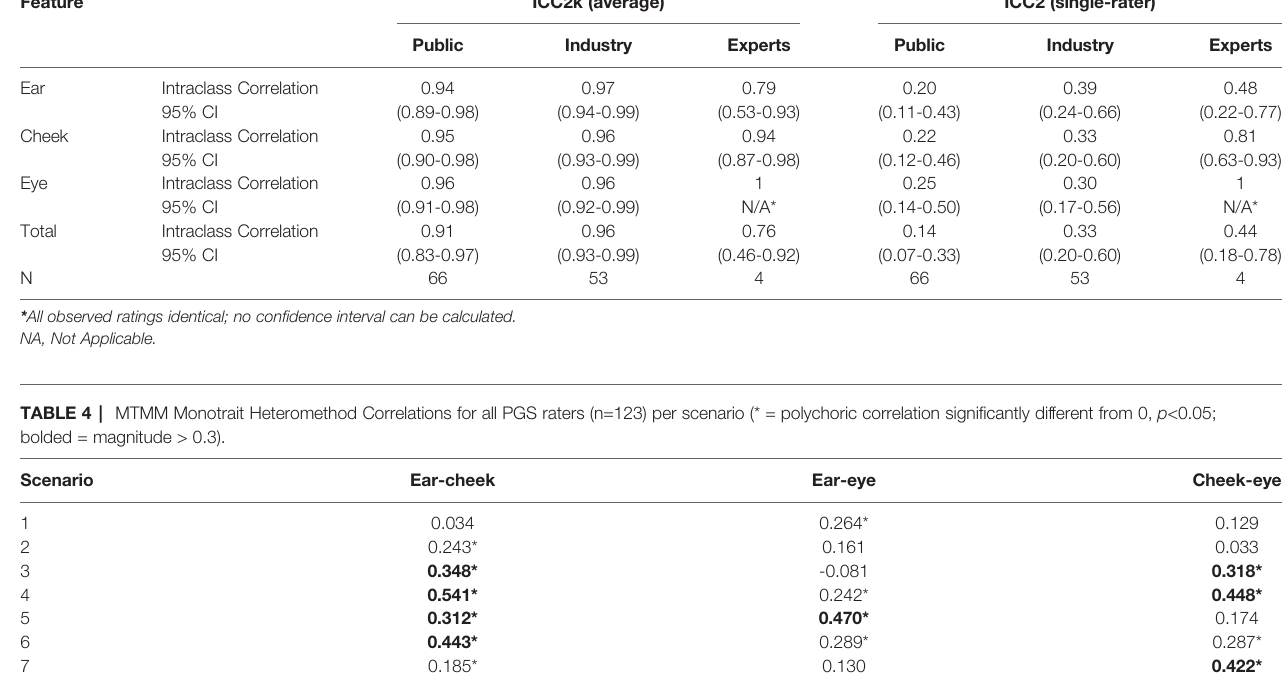
TABLE 3 | Average and Single-Rater Intraclass Correlation (ICC) with 95% Con fi dence Intervals (CI) by Piglet Grimace Scale (PGS) feature and total scores.